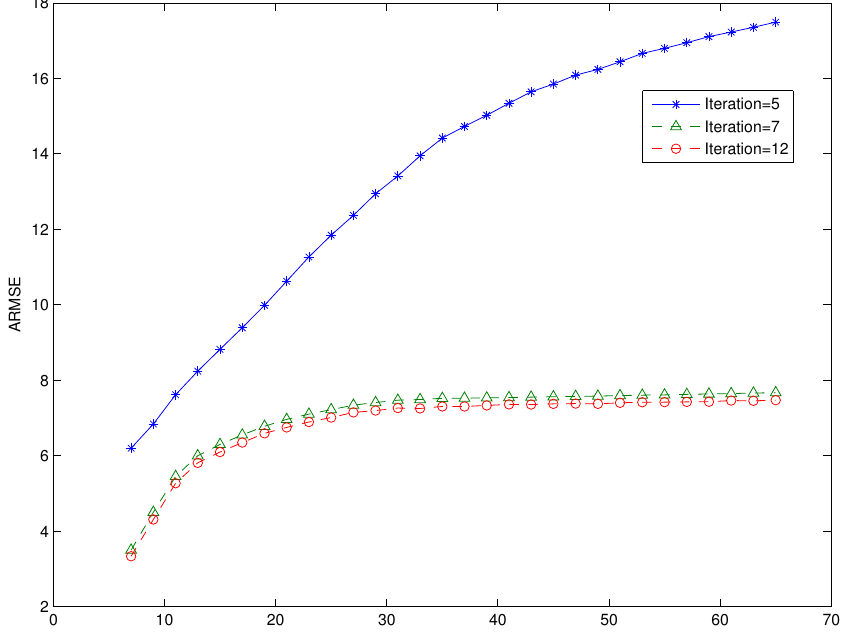
Figure 4. RMSE versus time for different iteration values of the consensus